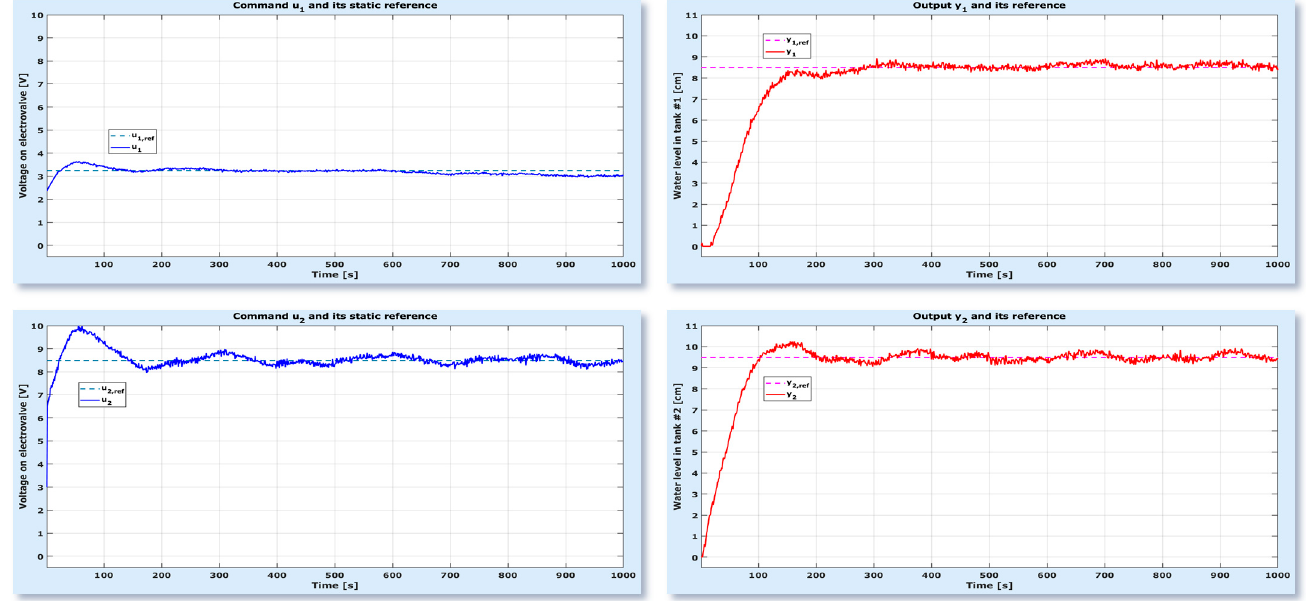
Φ IFA = 83.84%. 83.84 Φ = %. Figure 17. I/O signals for optimal PID-N controllers; in the case of <raw> idmo, o o